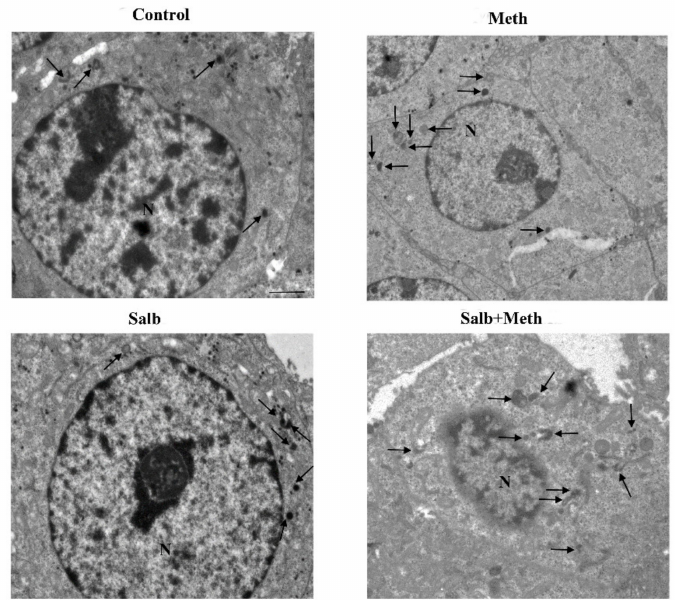
Figure 17. Representative TEM micrograph of autophagy-like vacuoles following salbutamol and Meth (low magnification). TEM micrographs at low magnification of Control, Meth (50 µ M), salbuta- mol (5 nM), or salbutamol (5 nM) + Meth (50 µ M)-treated cells. Images show autophagy-like vacuoles (arrow). Cells were fixed at 72 h after Meth administration. In the combined treatment, salbutamol was administered 30 min before with Meth. Scale bar = 1 µ M. N = nucleus.